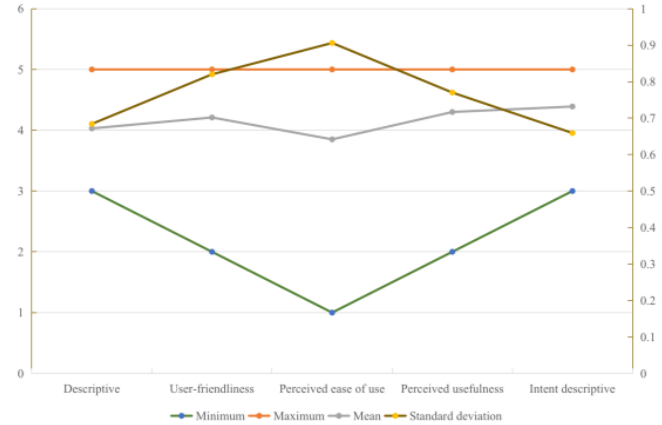
Figure 6. Interaction book model practicability analysis result scores.